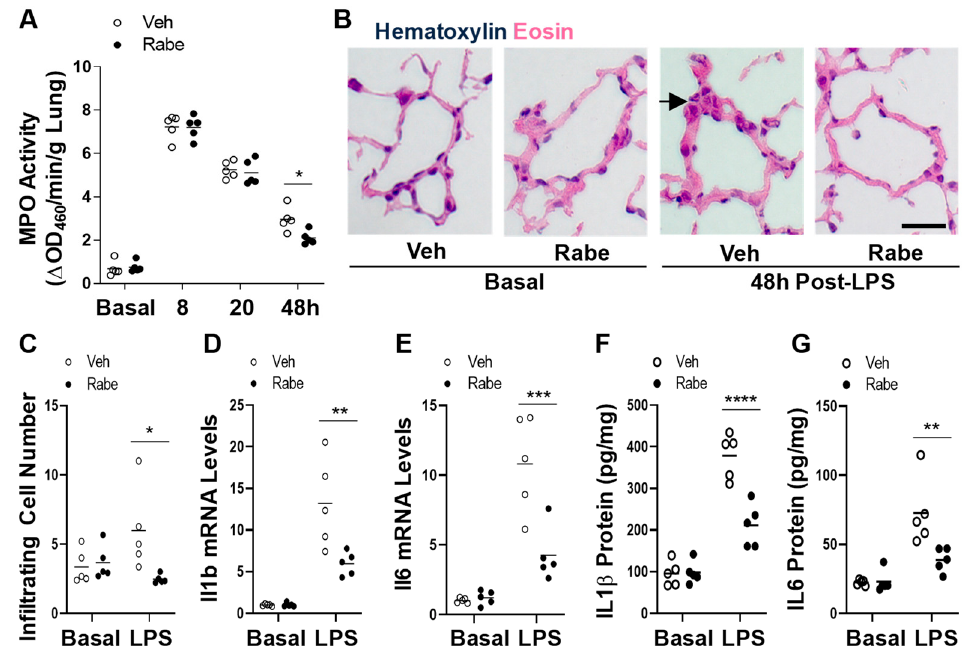
Figure 4. Rabeprazole promotes resolution of inflammation following sepsis challenge. ( A ) MPO activity assay showing Rabeprazole treatment resulted in reduced neutrophil sequestration during the repair phase (e.g., 48 h) after LPS challenge but not at baseline or during the injury phase (8 and 24 h). WT mice received PBS vehicle (Basal) or LPS (2.5 mg/kg, i.p.). At 4 and 20 h post-LPS, mice were treated with PBS vehicle or Rabeprazole (18 mg/kg, oral). ( B ) Representative images of infiltrating peri-vascular cells in H&E-stained lungs from basal and LPS-challenged mice at 48 h post-LPS. Arrow indicates infiltrated peri-vascular cells. ( C ) Quantifications of infiltrated proinflammatory cells per vessel < 150 µ m. ( D , E ) Quantitative RT-PCR and ( F , G ) ELISA analyses demonstrating Rabeprazole treatment inhibited expression of proinflammatory cytokines at 48 h post-LPS but not at baseline. Scale bar = 50 µ m. * p < 0.05, ** p < 0.01, *** p < 0.001, and **** p < 0.0001. Two-way ANOVA